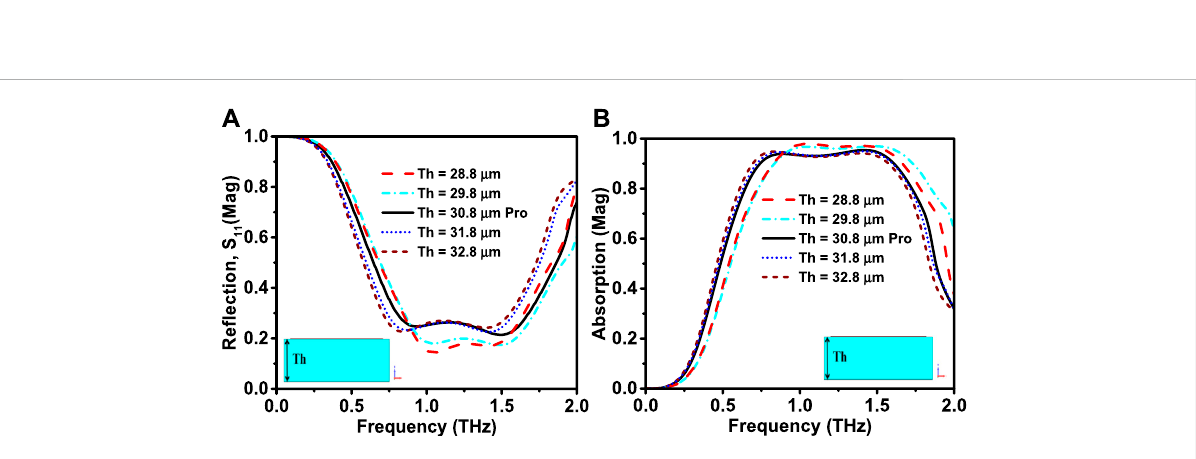
FIGURE 6 Simulated results of the effect of substrate thickness on the (A) re fl ection coef fi cient and (B) absorption coef fi cient of the